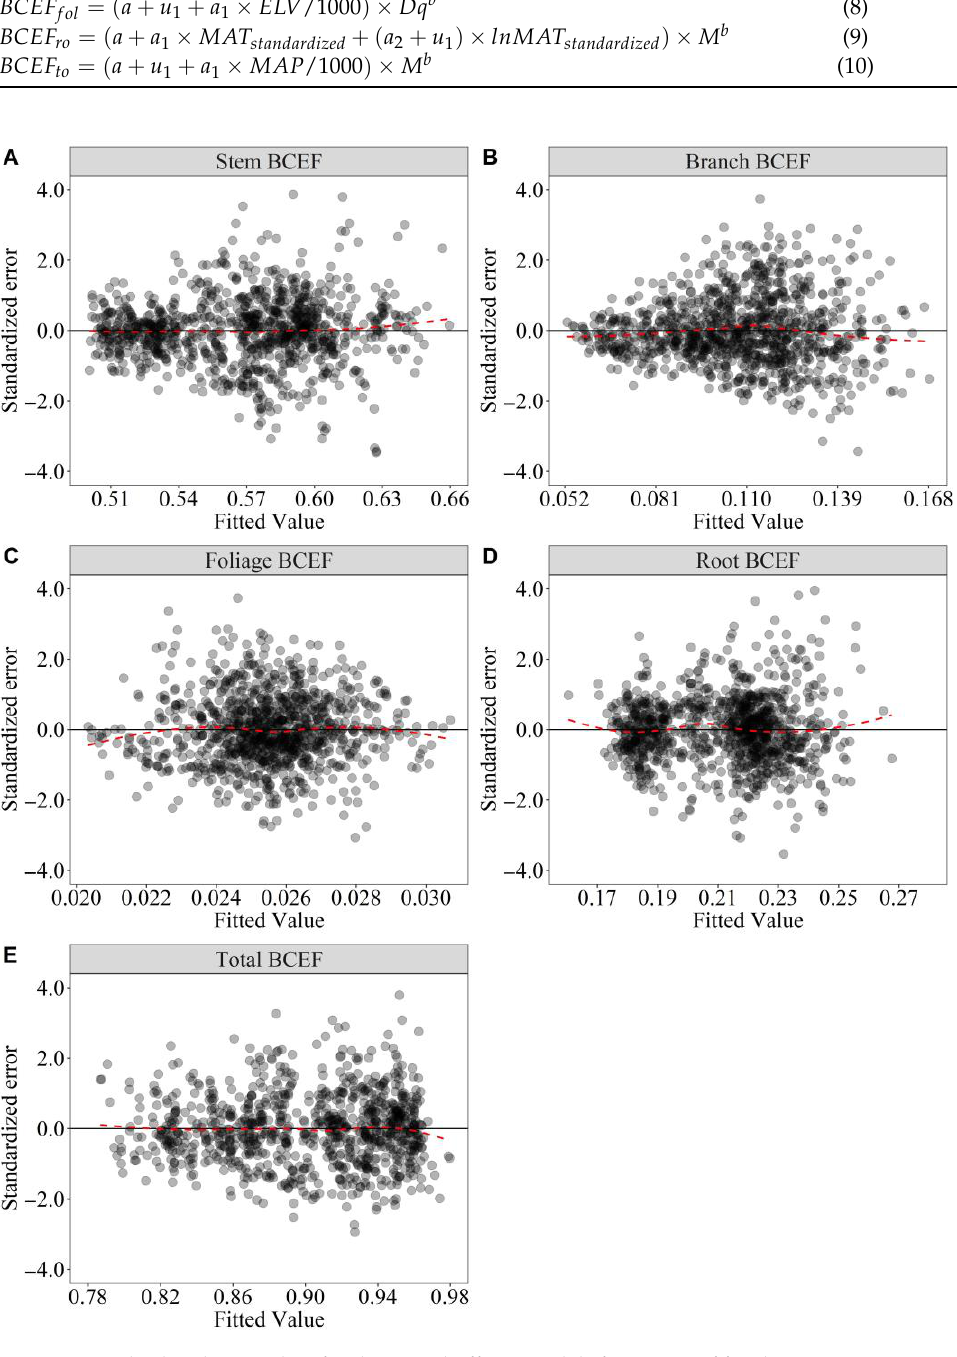
Figure 2. Standardized error plots for the mixed-effects models for 𝐵𝐶𝐸𝐹 𝑠 of five biomass compo- nents ((A): stem, (B): branch, (C): foliage, (D): root and (E):total) of the natural white birch forest . (( A ): stem, ( B ): branch, ( C ): foliage, ( D ): root and ( E ):total) of the natural white birch